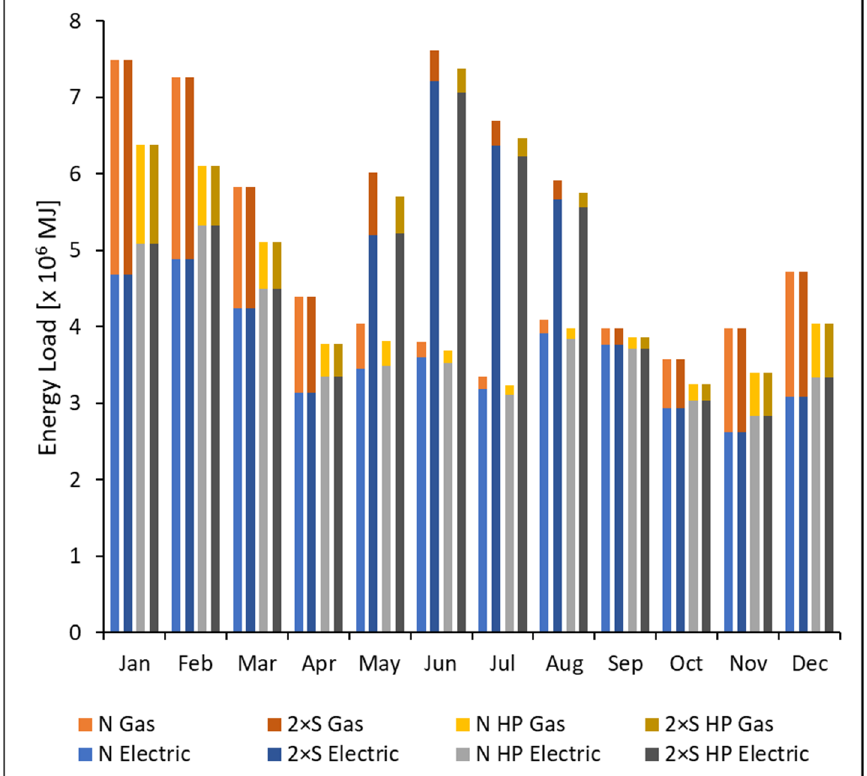
Figure 2. NWC Normal (N) and 2× Summer (2 × S) monthly energy load profiles. The 2 × S profile doubles the daytime load from 15 May to 15 August, resulting in a 19% annual load increase. The 2 × S June load also exceeds the normal peak load in January. Implementing Heat Pump (HP) technology lowers the annual load by 10% in both Normal and 2×S load scenarios, with the most significant impact in January and February.